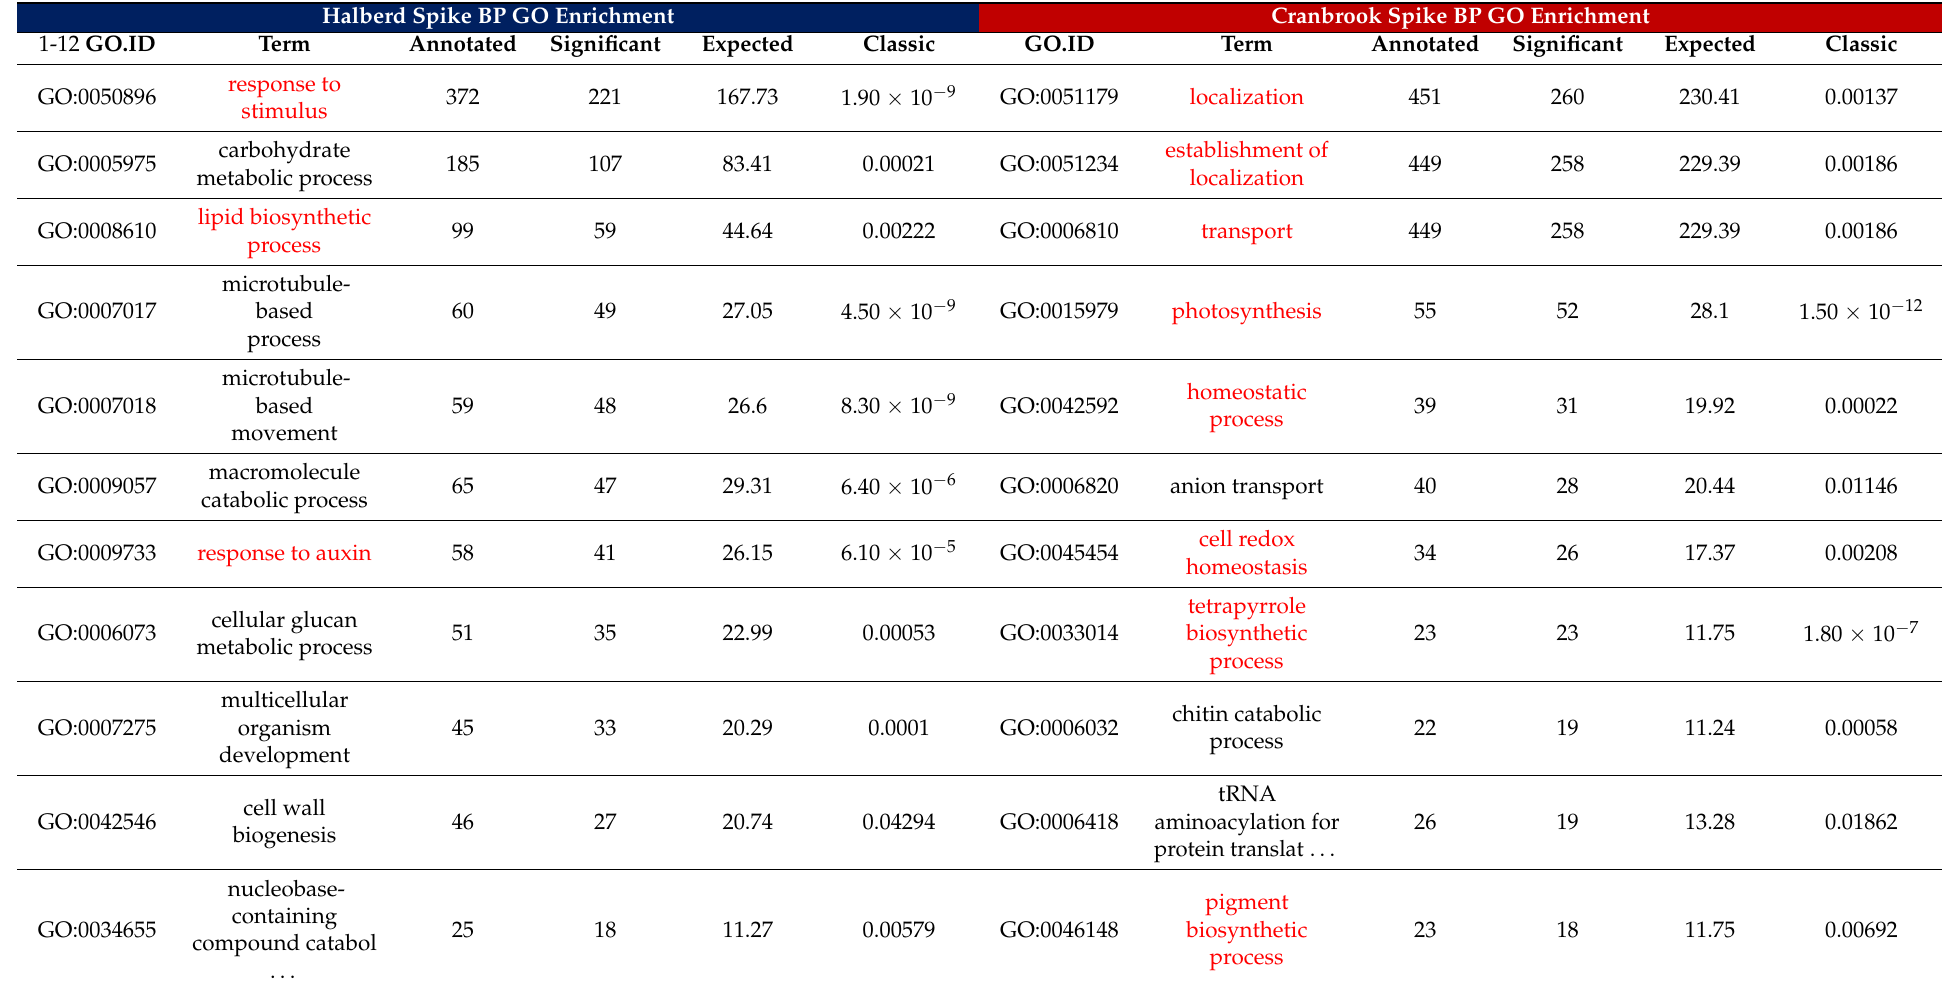
Table 2. GO enrichment analysis for biological processes (BP) using all Halberd and Cranbrook spike DEG. Halberd Spike BP GO Enrichment Cranbrook Spike BP GO